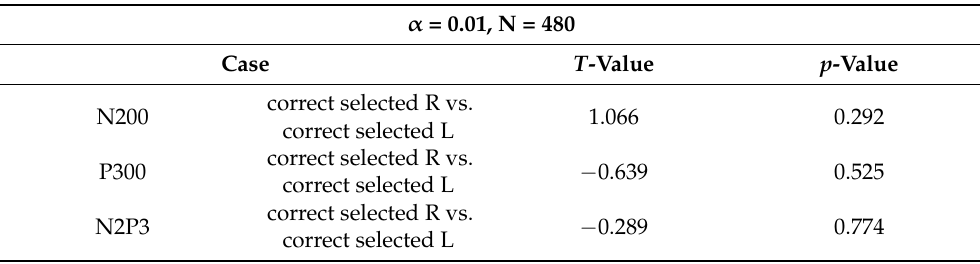
Table 11. Paired samples t-test results of average accuracies for every trial between correct selected R and correct selected